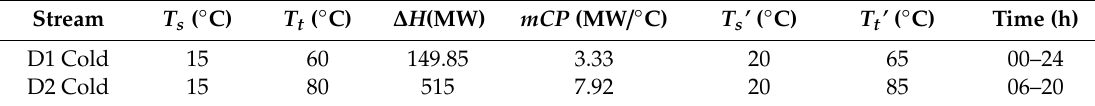
Table 5. Stream datafor Industrial Plant C with ∆ T min, pp = 10 ◦ C (modified from Jamaluddin et al. [27]).